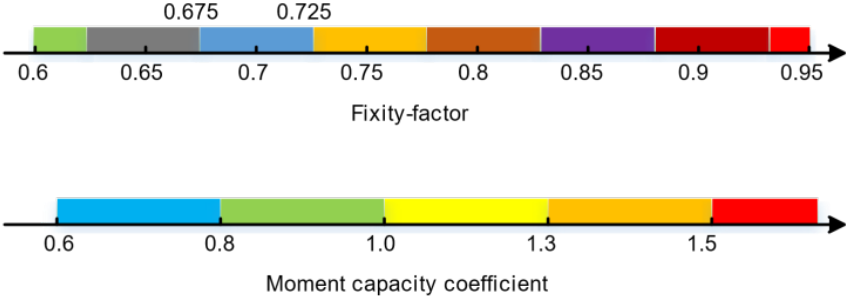
Figure 12. Performance segments of connections.